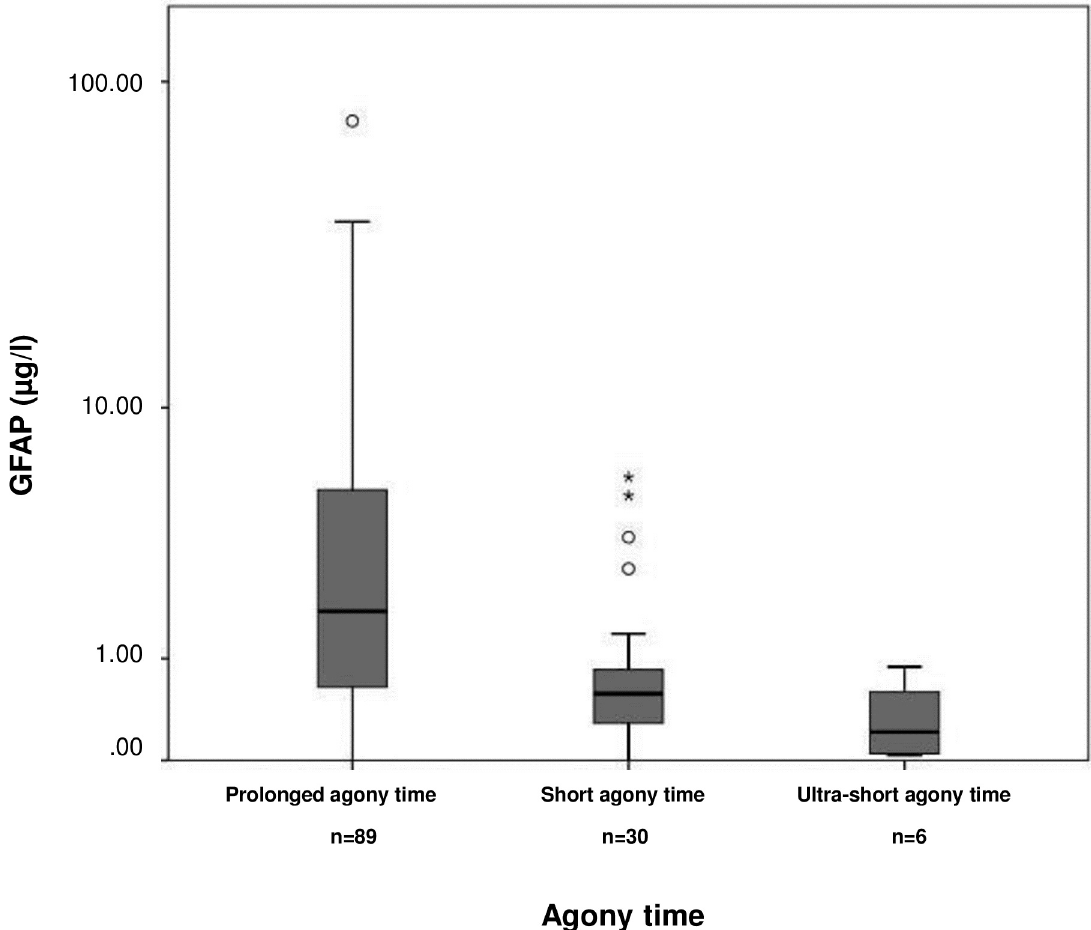
Fig 1. Post-mortem GFAP serum concentrations of the study population stratified according to agony time. The boundaries of the box indicate the 25 th and 75 th percentile, respectively. The whiskers indicate the 10 th and 90 th percentile, respectively. Outliers (between 1.5 and 3 times the interquartile range) are marked with circles. Extreme values ( > 3 times the interquartile range) are marked with asterisks. The y-axis is on a logarithmic scale. GFAP concentrations: ultra-short agony times (median 0.21 μg/l [IQR 0.12, minimum 0.03, maximum 0.89]; n = 6), short agony times (0.58 μg/l [0.58, 0.00, 5.87]; n = 30), and prolonged agony times (1.76 μg/l [4.68, 0.00, 76.25], n = 89; Kruskal Wallis p < 0.001; post-hoc ultra-short versus prolonged agony times p = 0.002, short versus prolonged agony times p < 0.001).